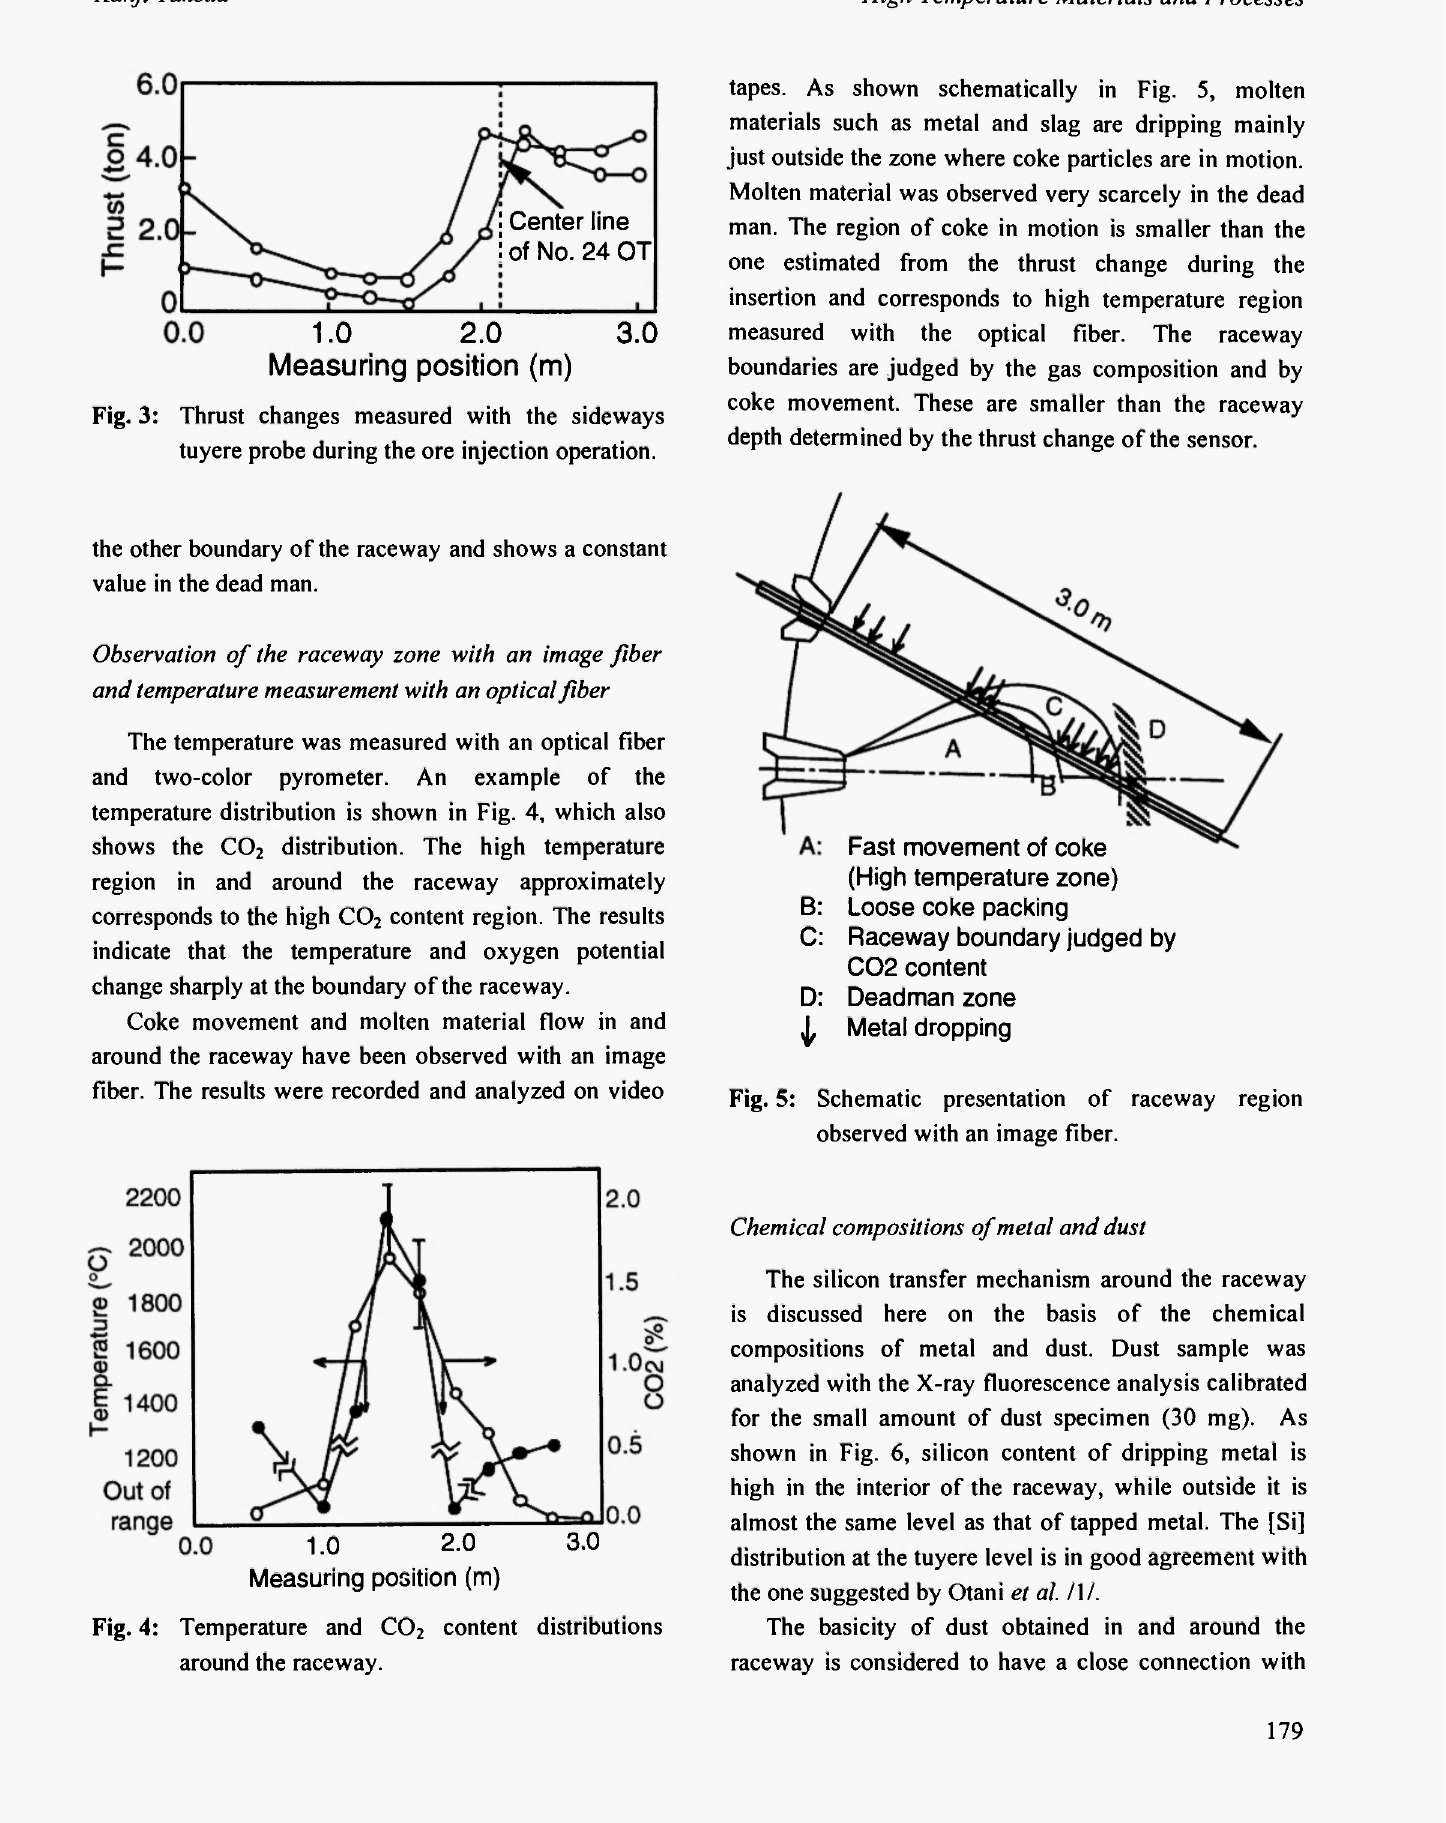
Measuring position (m)